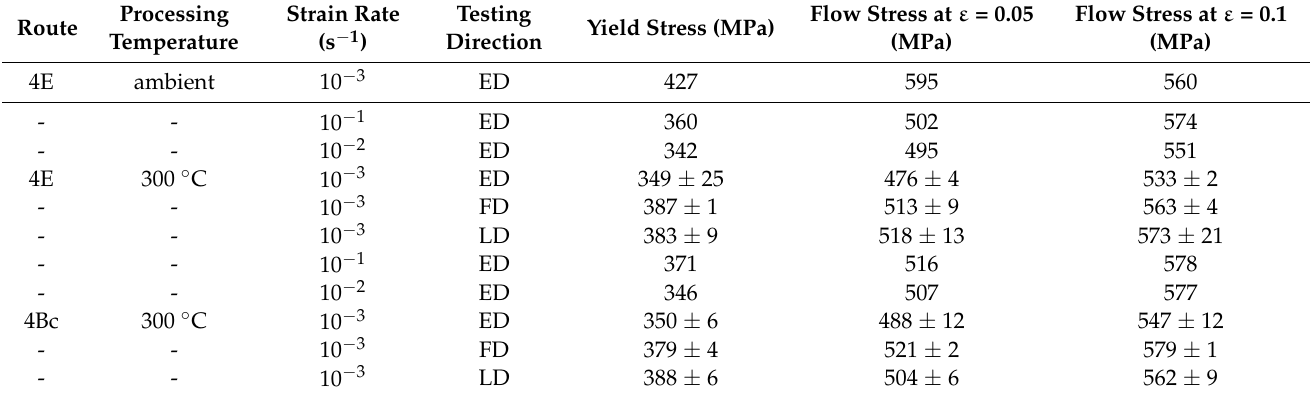
Table 3. Summary of compression test results on Cu-Ta composites processed by routes 4E and